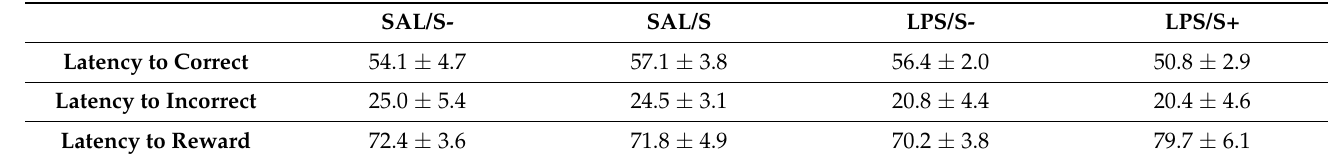
Table A1. 5-CSRT task speed